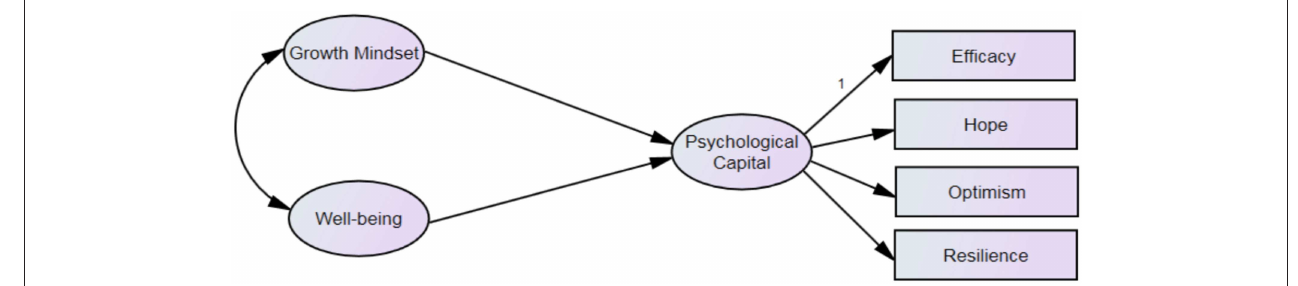
FIGURE 1 | A conceptual